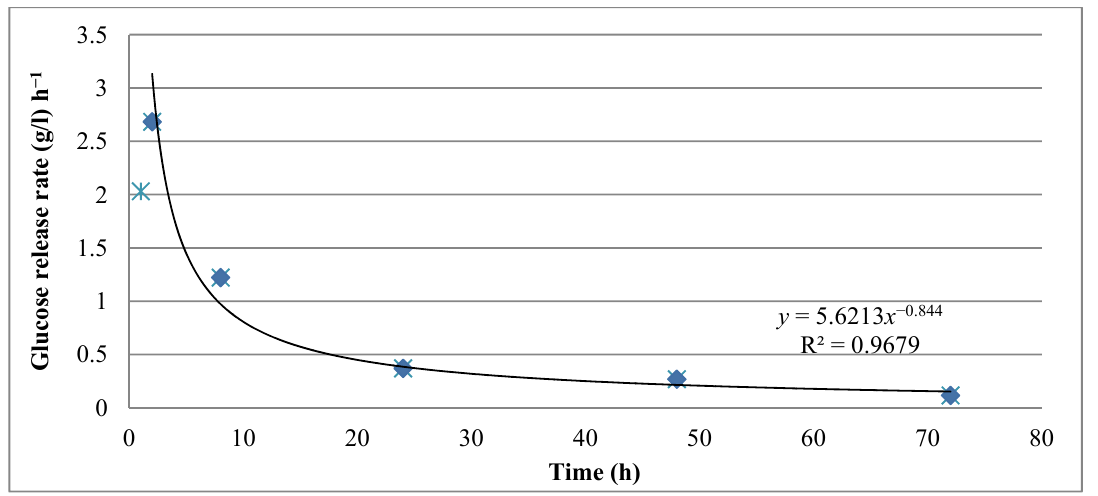
Figure 3. Glucose release rate vs . time for softwood pulp